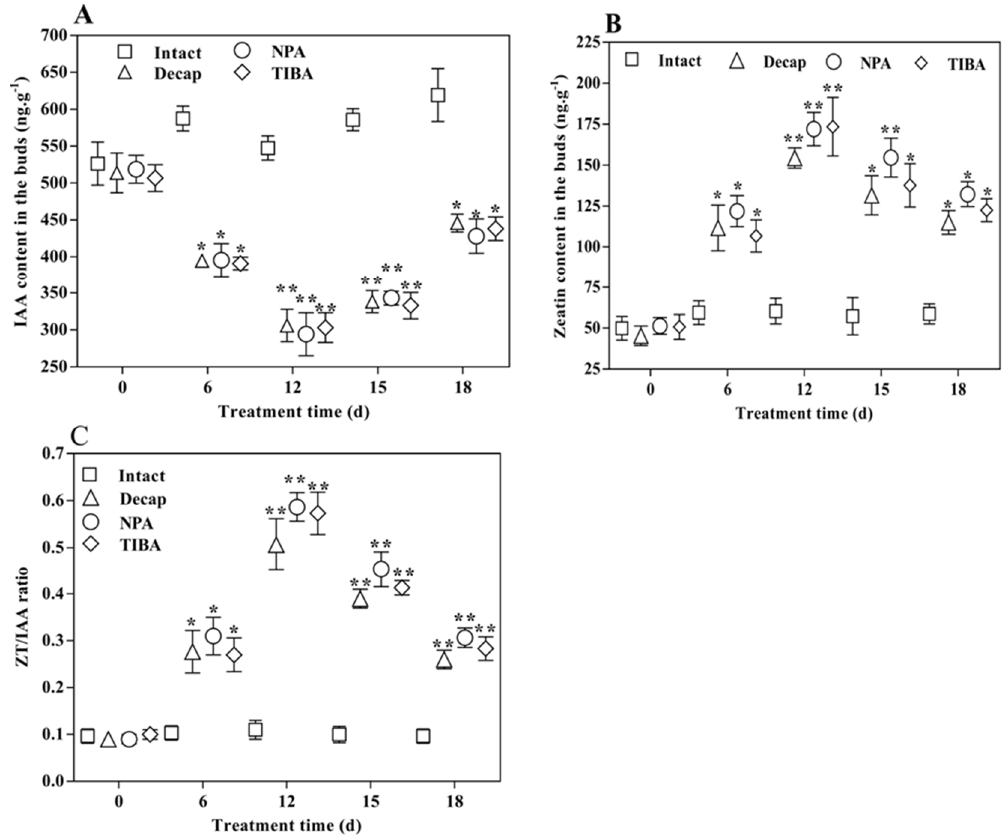
Figure 3. The phytohormone content of C. appendiculata lateral buds was tested during the bud elongation process by HPLC: ( A ) IAA; ( B ) zeatin; and ( C ) zeatin/IAA ratio. Values are means ± SD, n = 3. Error bars indicate the standard deviations obtained from three biological replicates. * and ** indicate significant differences based on one-way ANOVA tests at p < 0.05 and p < 0.01, respectively, compared with the intact group.